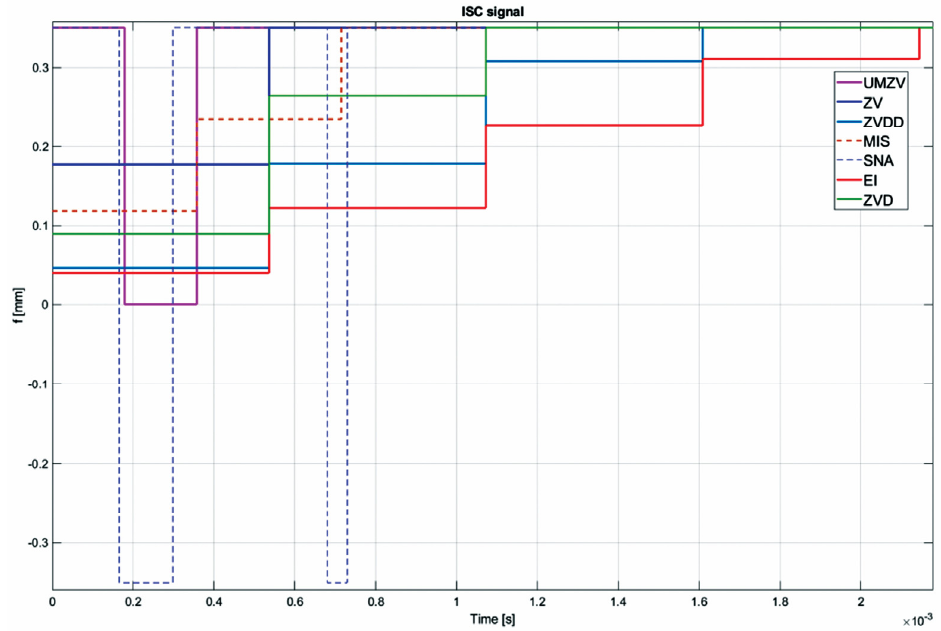
Figure 16. ISC signal of UMZV, ZV, ZVD, ZVDD, MIS, SNA and EI algorithm during precision machining.